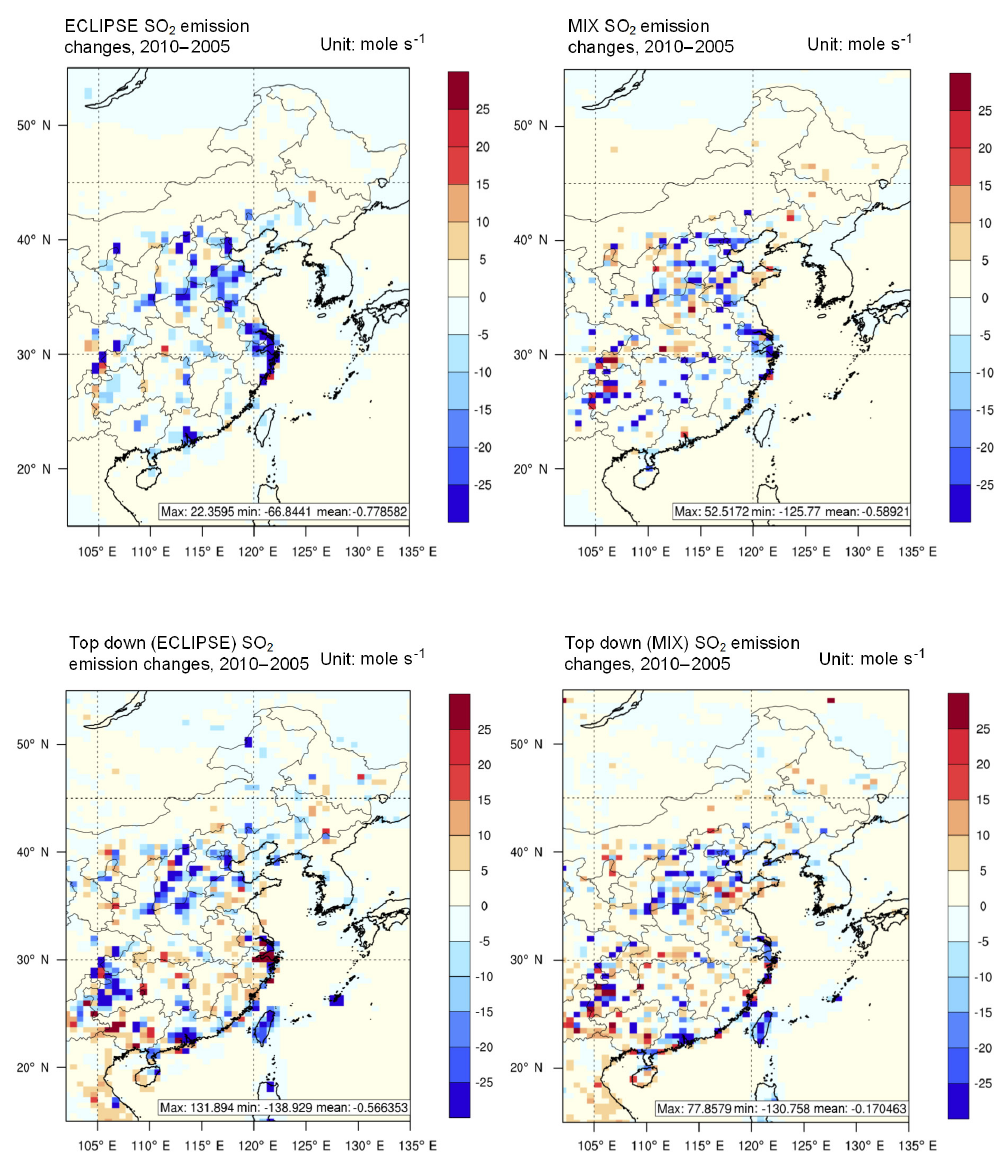
Figure 10. SO 2 emission changes from 2005 to 2010, estimated by ECLIPSE, MIX and a derived top-down inventory for each case; summer average